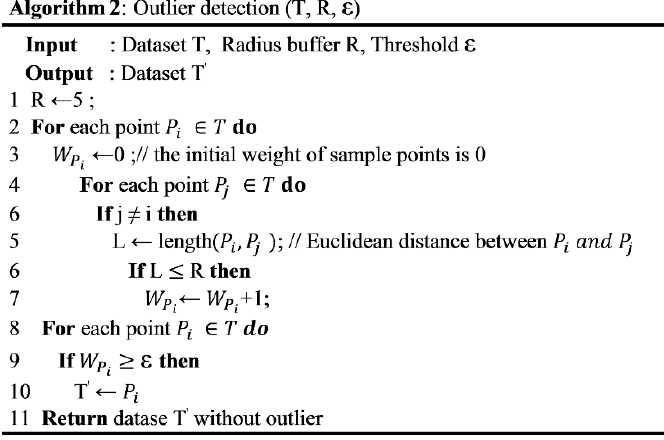
Figure 11. Pseudo-code depicting Algorithm 2.